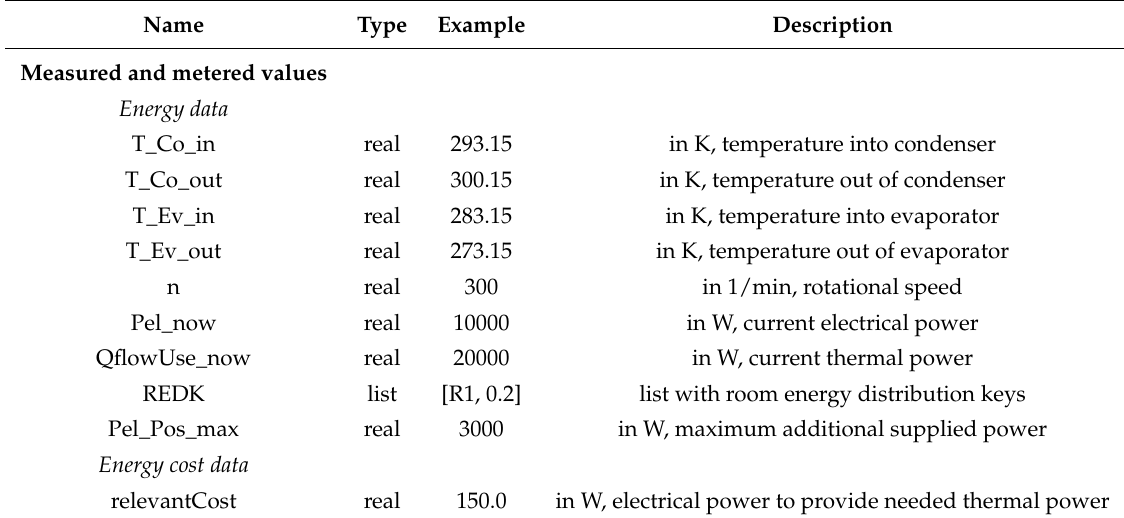
Table 1. Part of the data model for a heat